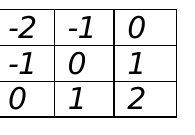
Table 3 . Sobel Right Diagonal 3x3 (left). Laplace Filter (right).